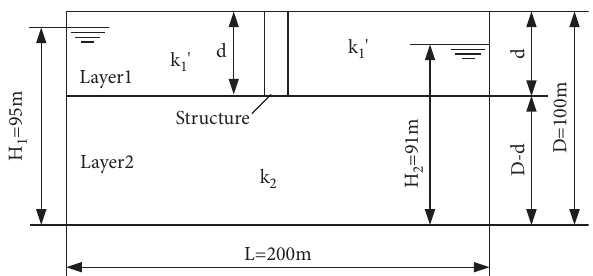
Figure 17: Simplifed schematic diagram of two-layer